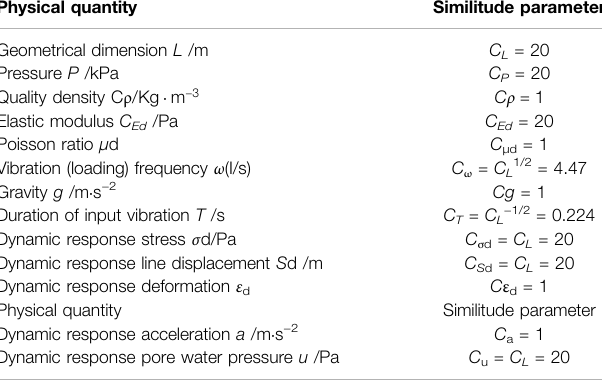
TABLE 3 | Dynamic similarity constants of laboratory tests.